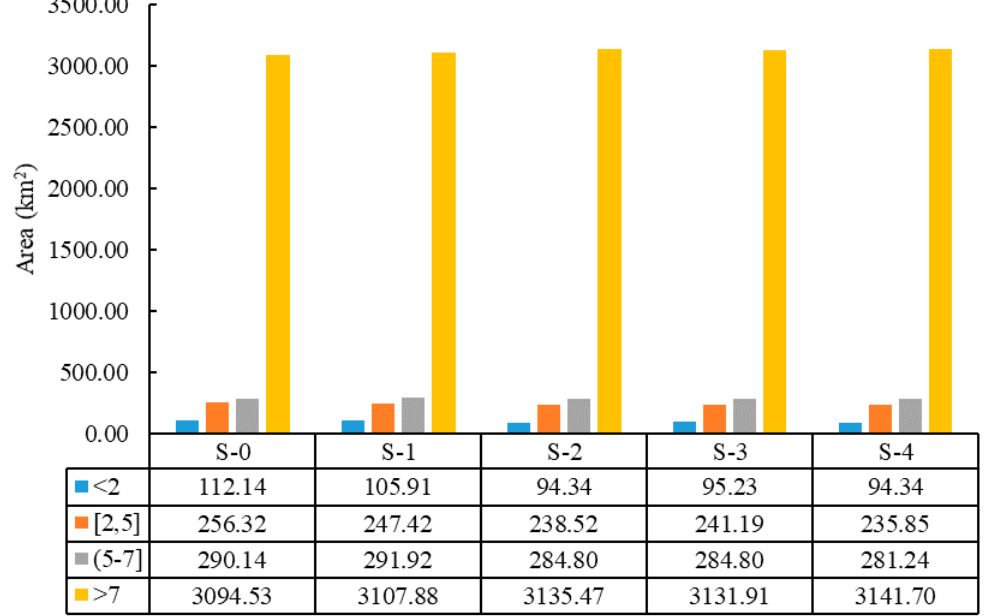
ff erent groundwater depth ranges in scaled water-saving irrigation Figure 7. Areas of different groundwater depth ranges in scaled water-saving irrigation scenarios. Figure 7. Areas of di